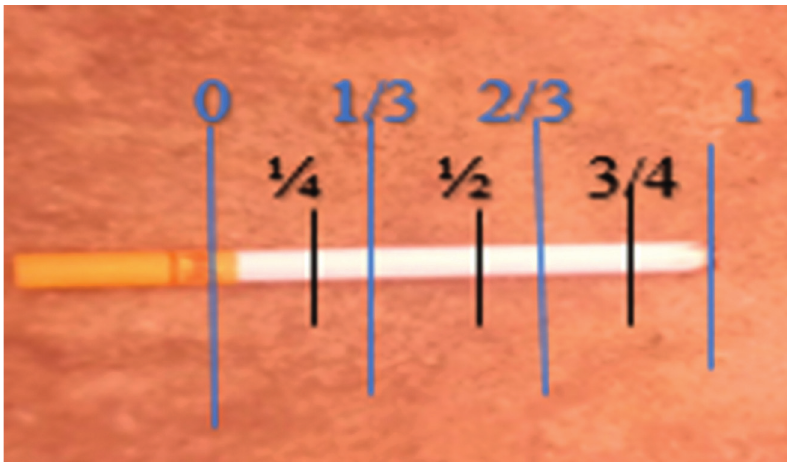
Figure 1: Possible lengths of cigarette butts containing remnant tobacco.